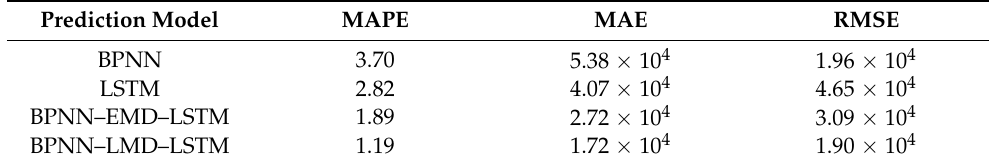
Table 4. Performance of different machine-learning and deep-learning models for UCI datasets. Prediction